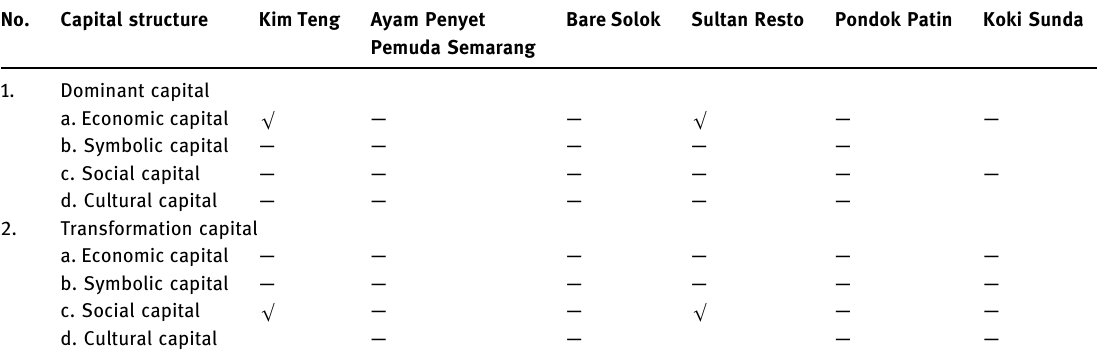
Table 4: The fi eld of